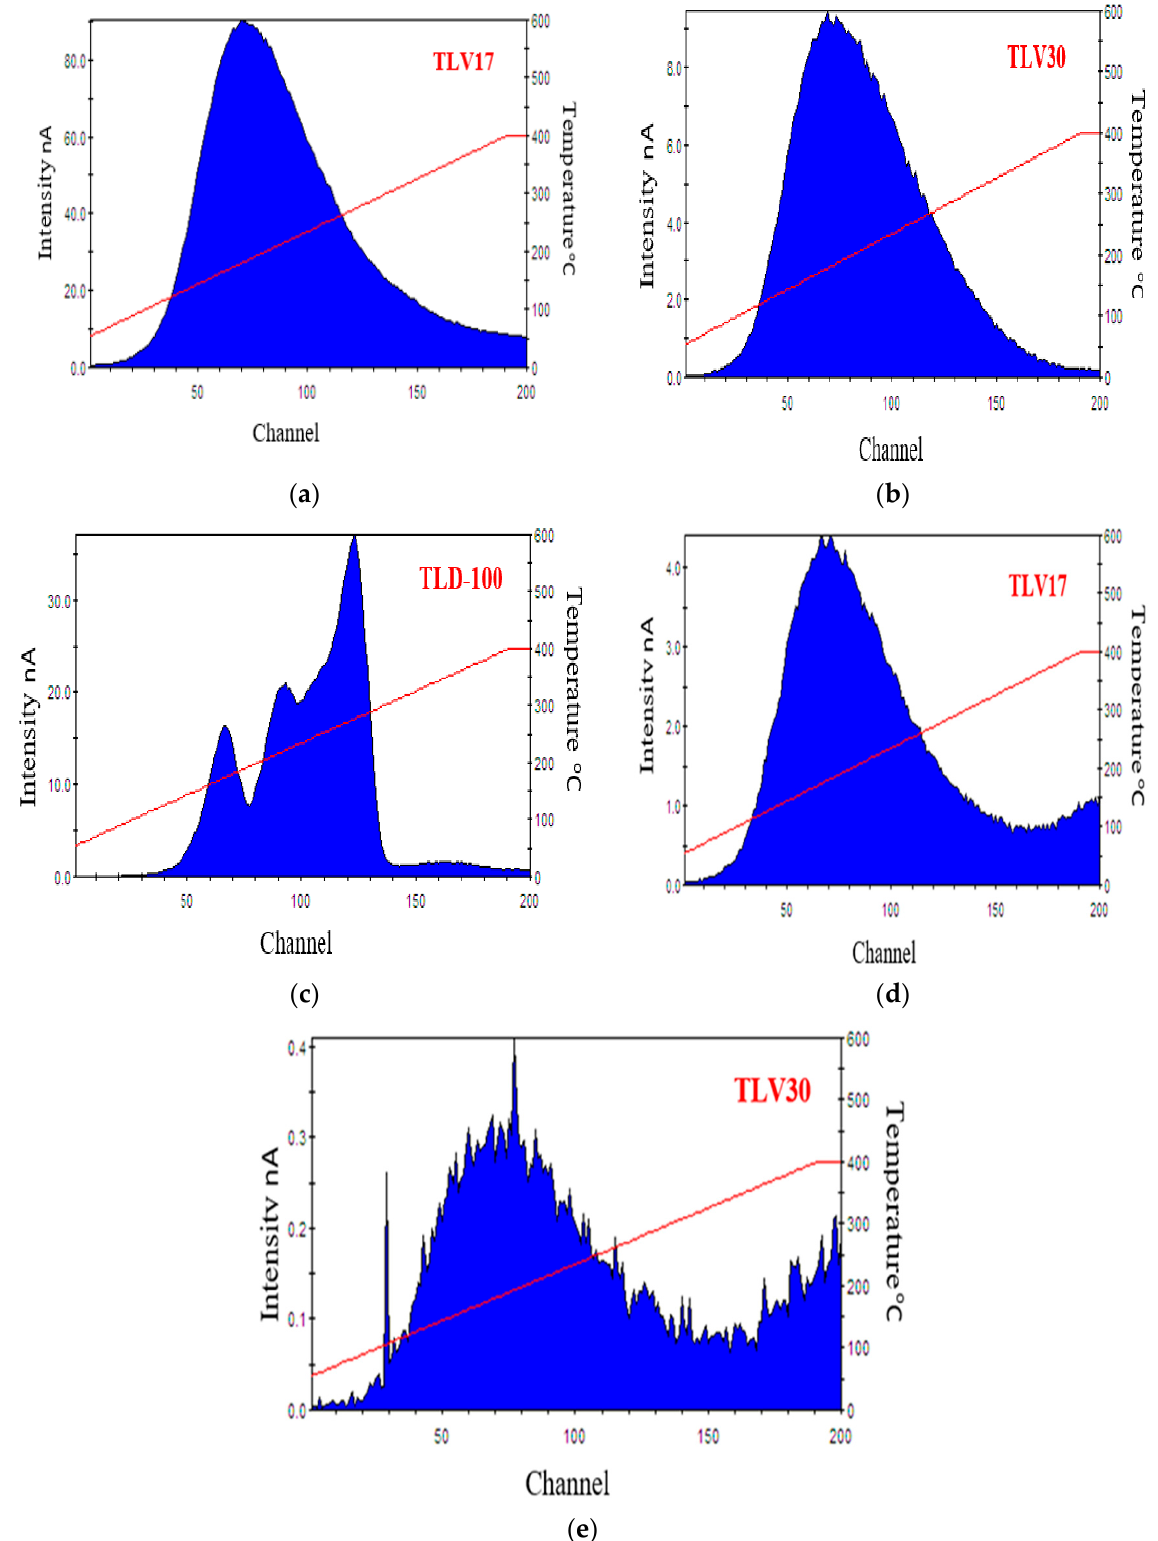
Figure 5. ( a – c ) The glow curves for the TLD samples at a dose of 50 mGy at 120 kVp. ( d , e ) The glow curves from a 2 mGy dose from a mammography machine at 28 kVp.